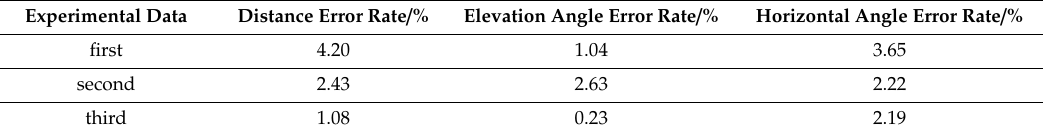
Table 5. Experimental data error rate in the three-plane